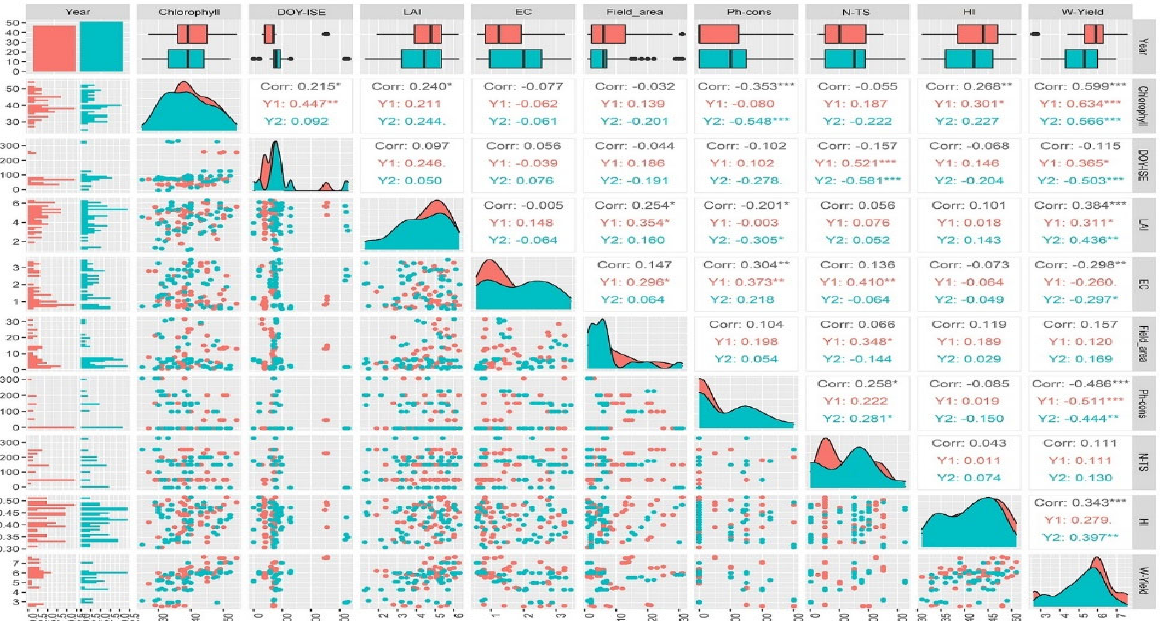
Figure 4. Correlation between eight variables extracted from the CPA approach in total and separately in two years of study. (From left to right, year 1 and 2, the amount of leaf chlorophyll, irrigation at stem extension stage, LAI, soil salinity, field area, phosphorus consumption, nitrogen at the tillering stage, harvest index, wheat yield). Significance level: *** p < 0.001; ** p < 0.01; * p < 0.05.